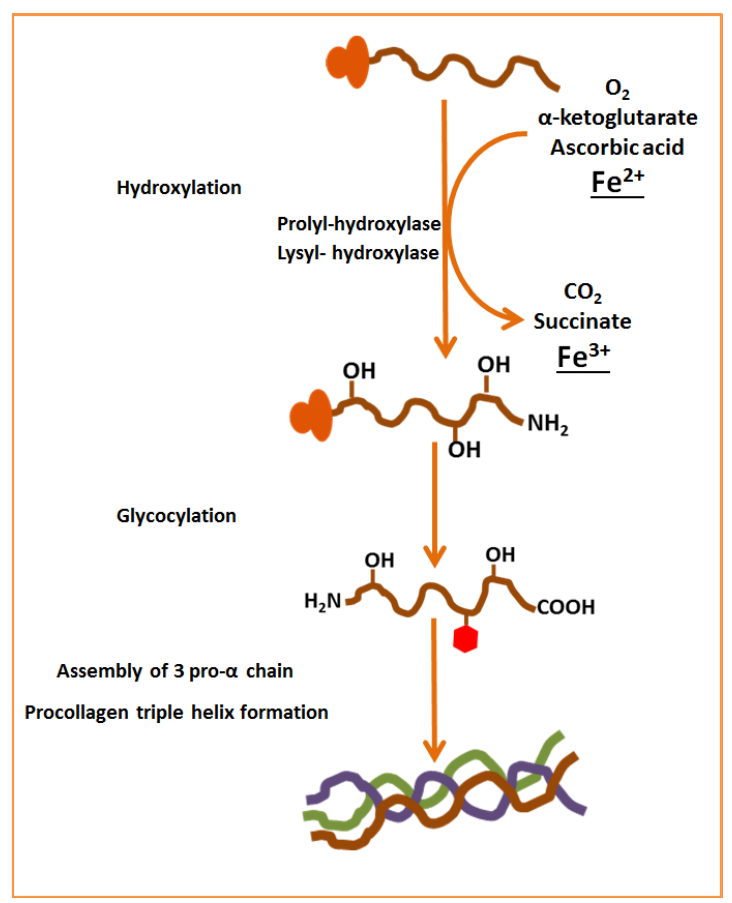
Figure 3. Role of iron in the collagen